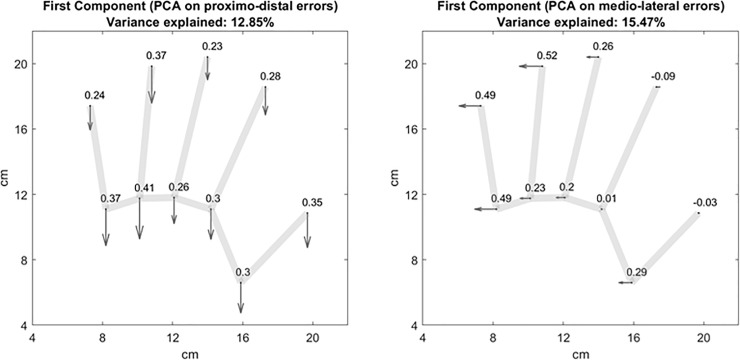
The PC1s (first principal components) of the PCAs on proximo-distal (left panel) and medio-lateral (right panel) errors are represented starting from the average positions of the actual hand landmarks. For each hand landmark, the average error of the PC1 is represented as a vector along with its loading.